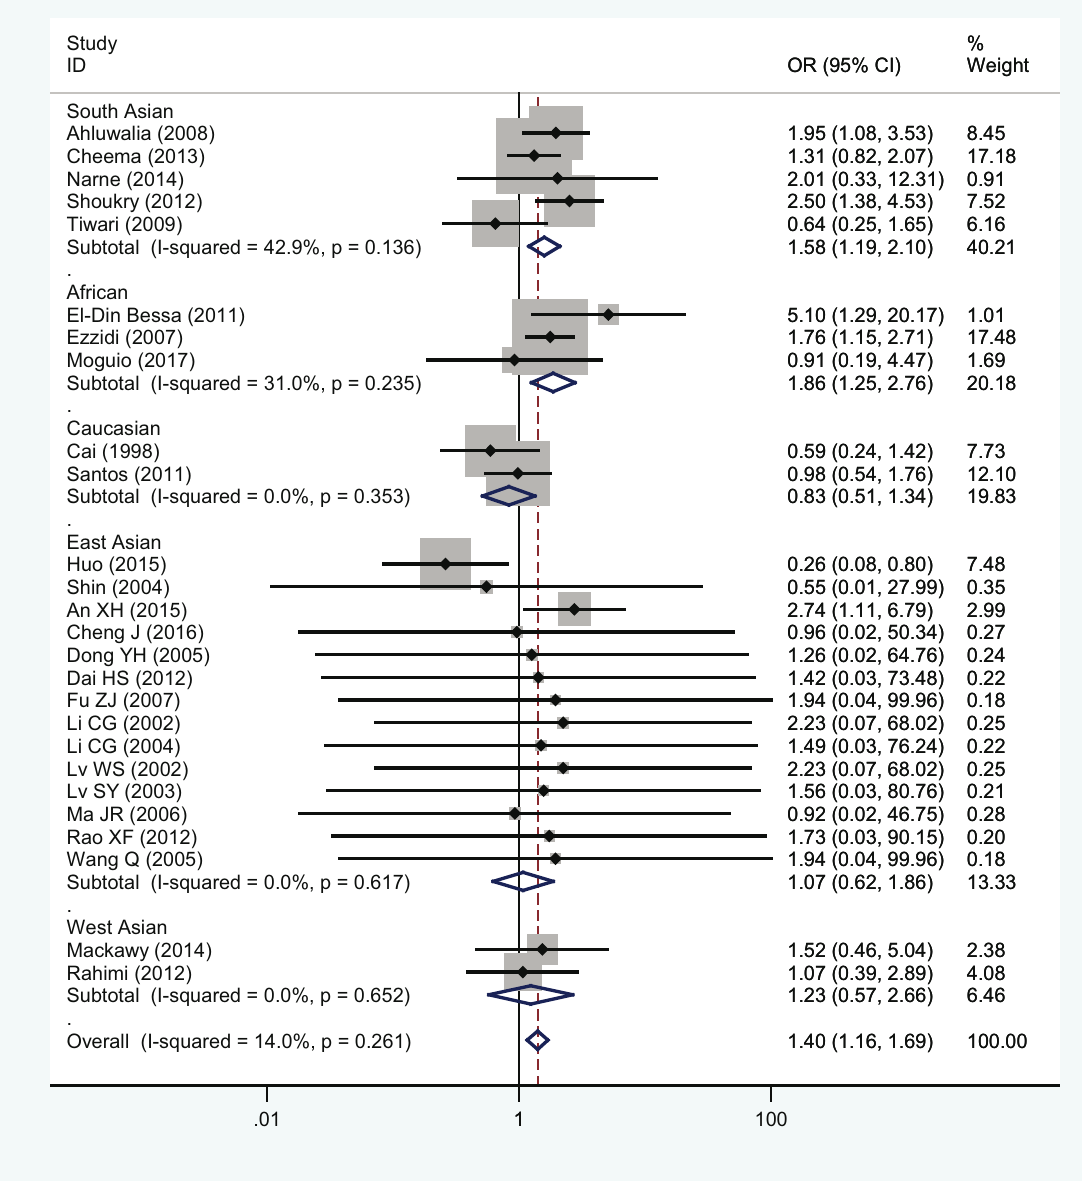
Figure 2: Forest plot of eNOS 894 G < T polymorphism and DN susceptibility in homologous gene model ( TT vs GG )